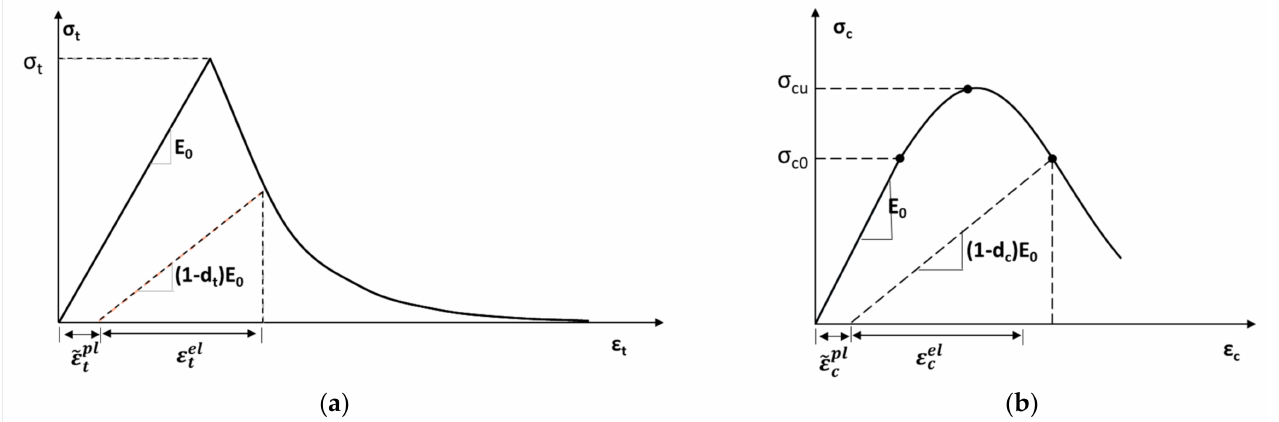
Figure 18. Constitutive relationship: ( a ) tension, ( b ) compression